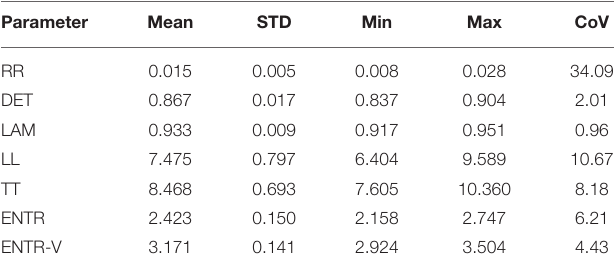
TABLE 2 | Descriptive statistics of the 21 football matches, including the coefficient of variation (CoV) for football-specific recurrence parameters.